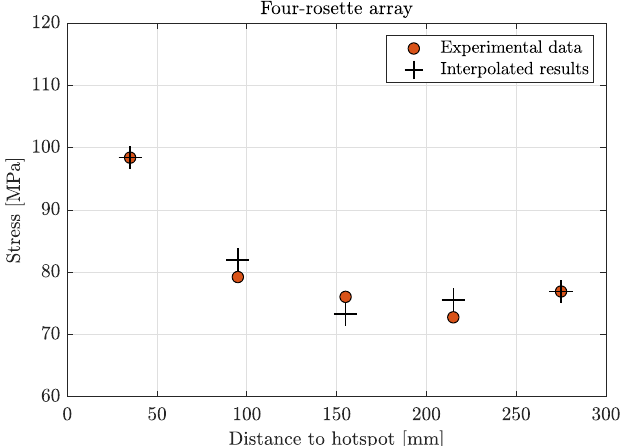
Figure 7. Comparison between the experimental measurements and interpolated results based on an optimised rosette